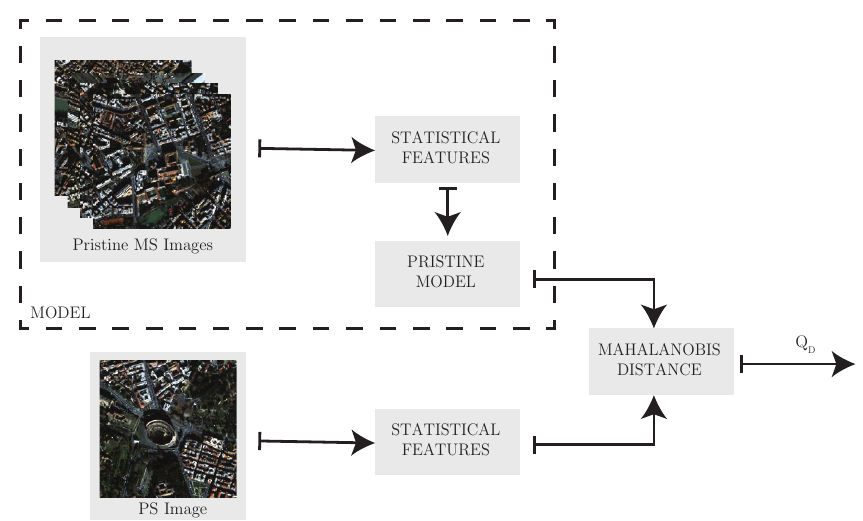
Figure 5. Flowchart of the opinion- and distortion-unaware quality analyzer.